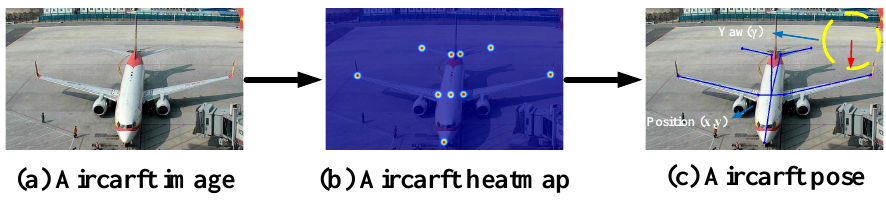
Figure 1. ( a ) Synthetic high-resolution aircraft image of virtual scene and ( b ) low-resolution aircraft image of realistic scene.